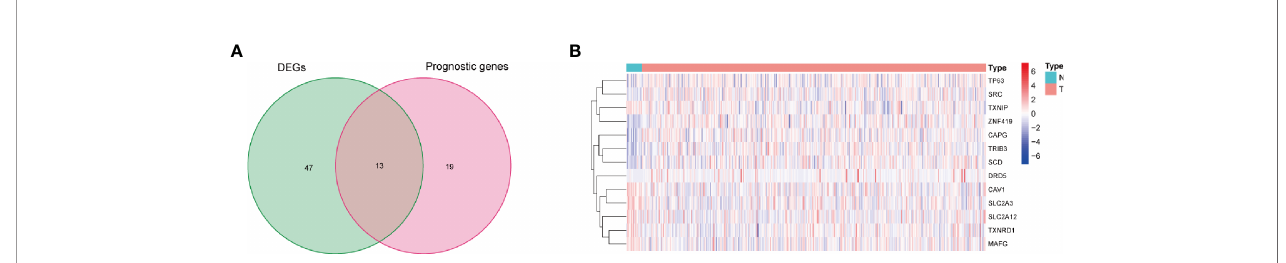
FIGURE 2 | Identi fi cation of prognostic ferroptosis-related differentially expressed genes. (A) Venn diagram for identifying ferroptosis-related DEGs related to OS. (B) Expressions of thirteen overlapping genes, in which the upregulated and downregulated DEGs were indicated in red and blue, respectively, and N and T represented adjacent normal samples and tumor samples, respectively.